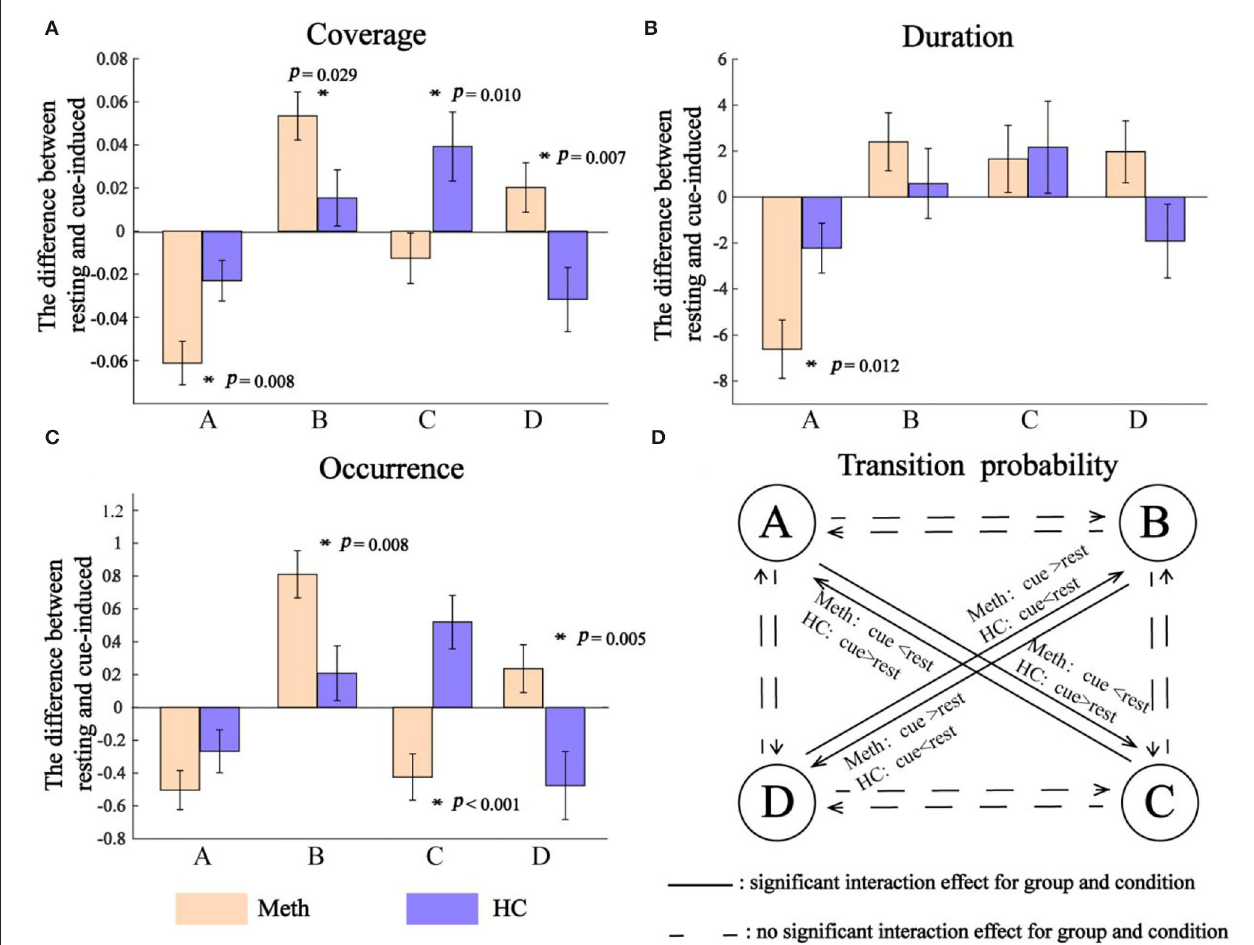
FIGURE 4 | Interaction between group and condition. (A) Coverage, (B) duration, and (C) occurrence. Positive value indicates an increasing microstates feature from resting to cue-induced condition, while negative value represents a decreasing microstates feature. Significant interaction between group and condition is indicated by asterisks. (D) Transition probability. The solid line indicates a significant interaction between group and condition for transition probability of A → C, C → A, B → D, and D → B,